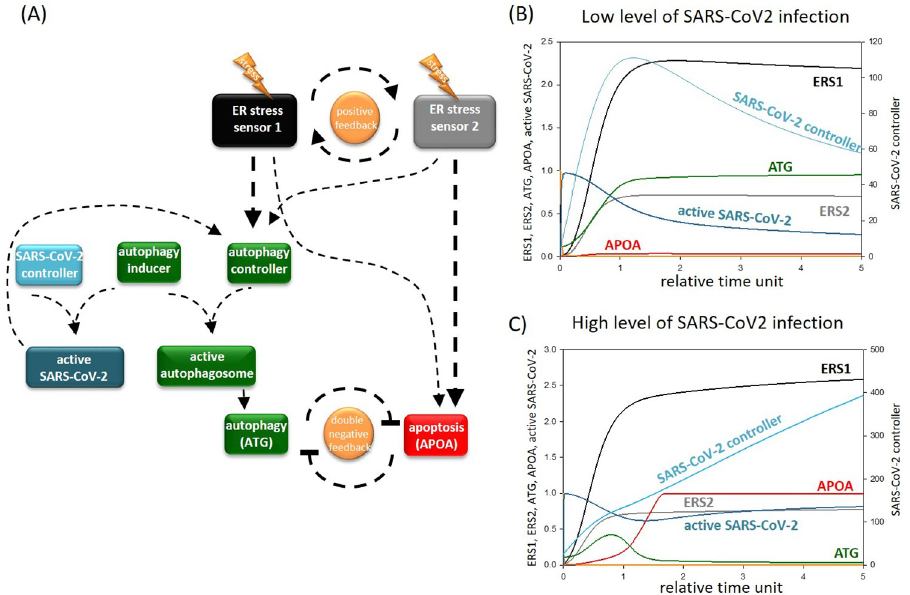
Fig 3. The simple network of autophagy-dependent survival in the presence of SARS-CoV-2. (A) The wiring diagram of the response mechanism . The active form of the ER stress sensor 1 and 2, autophagy inducer, autophagy controller, active autophagosome, SARS-CoV-2 controllers, active SARS-CoV2, ATG and APOA are grouped together in isolated coloured boxes. ATG represents the active form of autophagy activator complex, while APOA represents the active form of apoptosis. Dashed lines show how the molecules can influence each other. Blocked end lines denote inhibition. The temporary profile of computational simulation of (B) mild and (C) severe coronavirus infection . In case of mild infection CVCT (the initial conditions of SARS-CoV-2 controller) is set to 5 and in case of severe infection CVCT is set to 25 (for the code see S1 File). The relative activity of ER stress sensor 1 (ERS1), ER stress sensor 2 (ERS2), SARS-CoV-2 controller, form of active virus, ATG and APOA is plotted.